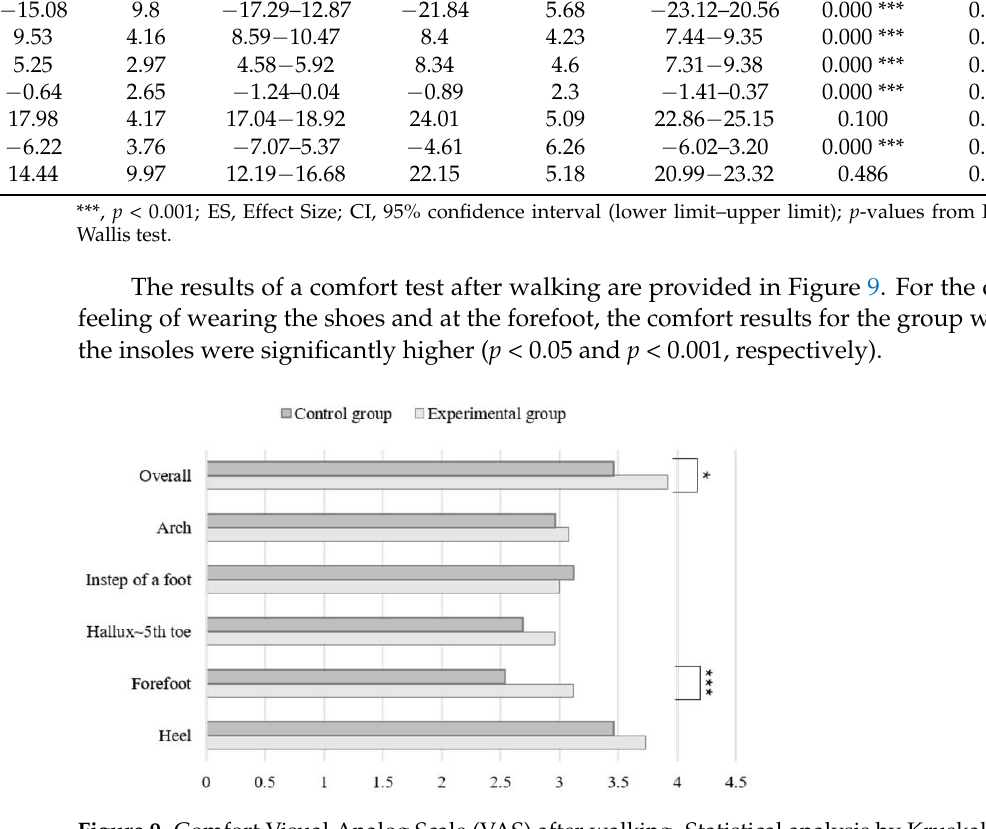
Figure 9. Comfort Visual Analog Scale (VAS) after walking. Statistical analysis by Kruskal – Wallis test; *, p < 0.05; ***, p <